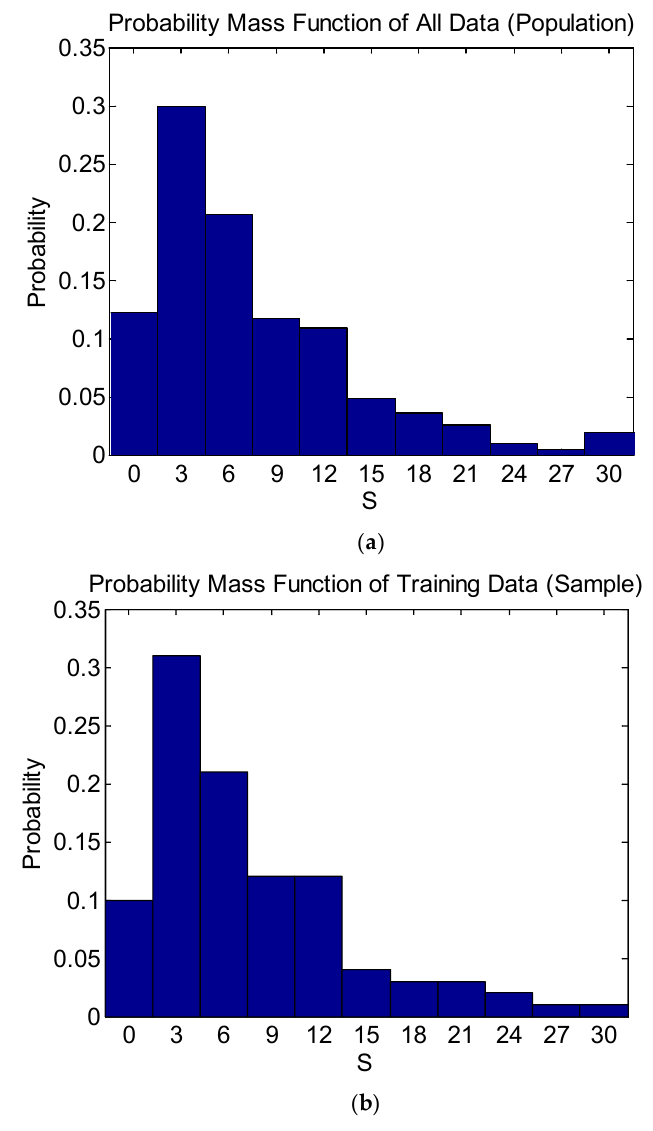
Figure 3. Probability mass functions of damage level S : ( a ) population; ( b ) training data.